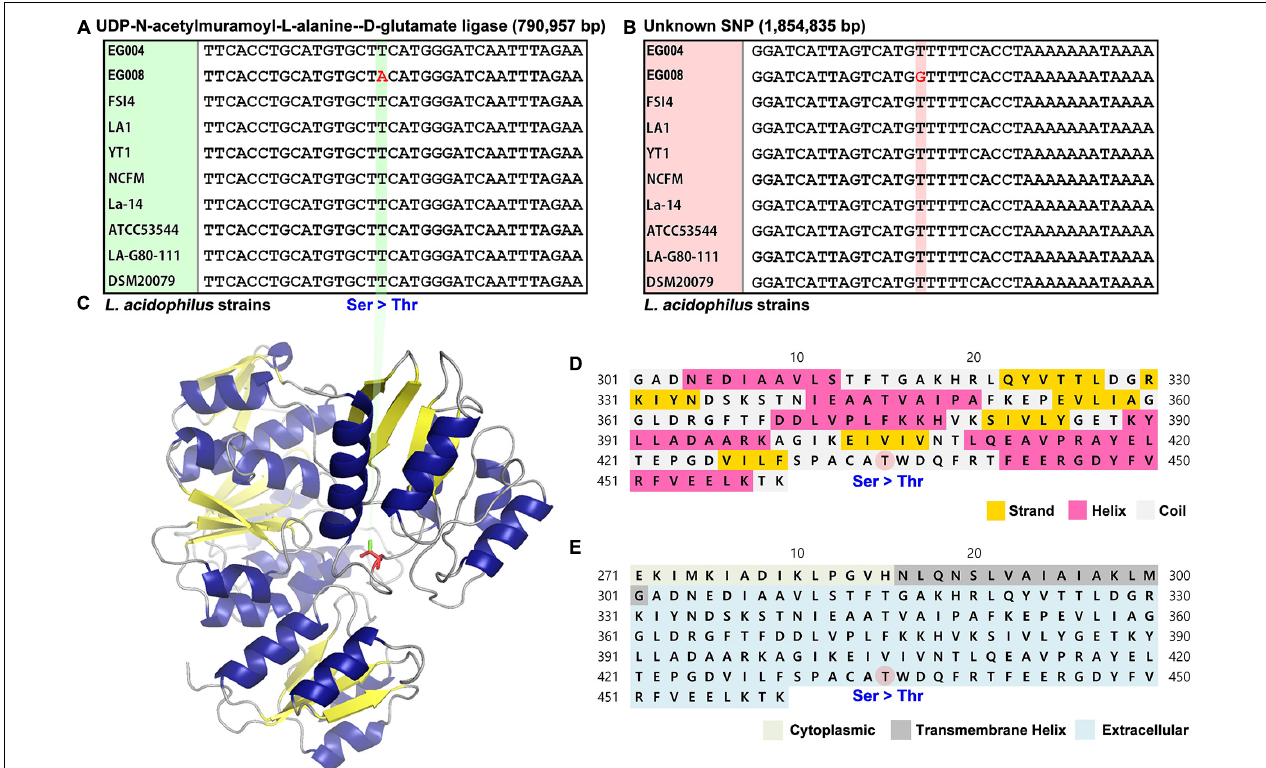
FIGURE 4 | Two single-nucleotide polymorphisms (SNPs) were found by comparing the complete genome sequences of L. acidophilus EG004 and EG008 strains. (A) A non-synonymous SNP is located at 790,957 bp of genic region in EG008 strain. This genotype change causes the serine amino acid to be transformed into threonine. (B) A SNP found in the intergenic region of the EG008 strain. (C) Prediction of 3D structural change of MurD protein by the identified non-synonymous SNP. The serine-to-threonine changes trigger a change from hydroxyl to acyl group (red) in the side chain. (D) The 435th amino acid of the secondary structure is predicted to be the coli part by PSIPRED tool. (E) It is the part of the coil that connects the beta sheet of the third domain and the alpha helix, which is located on the extracellular